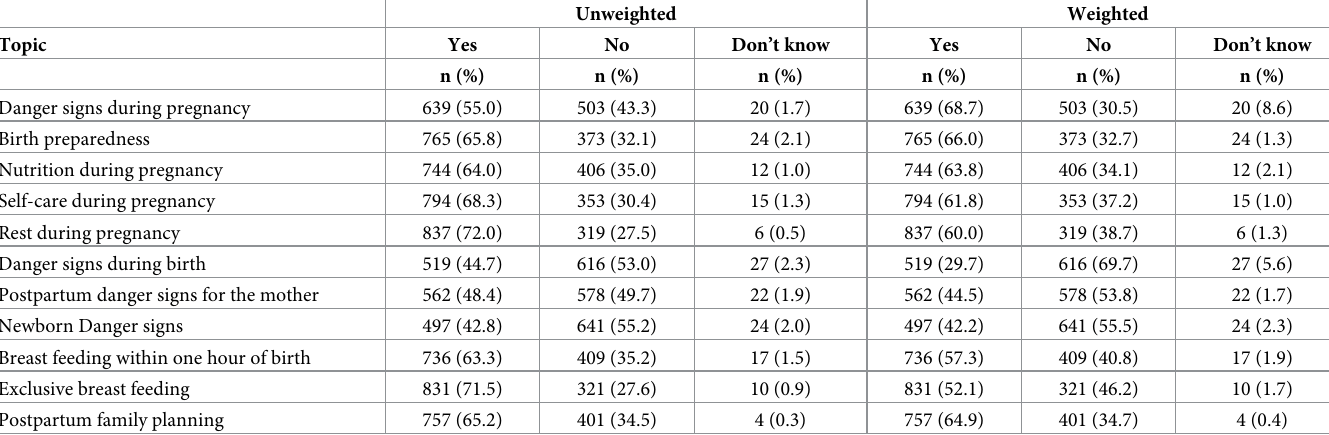
Table 3. Proportion of women who reported received counseling on various topics during ANC in Mara and Kagera, Tanzania (n =